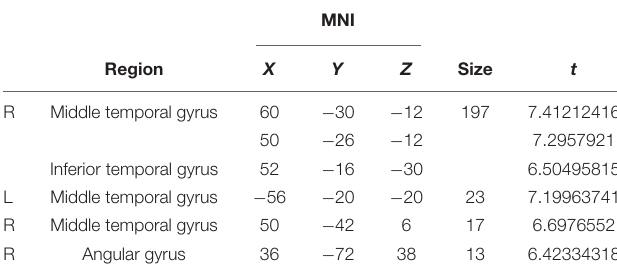
TABLE 4 | Omission activation (OMISSION >